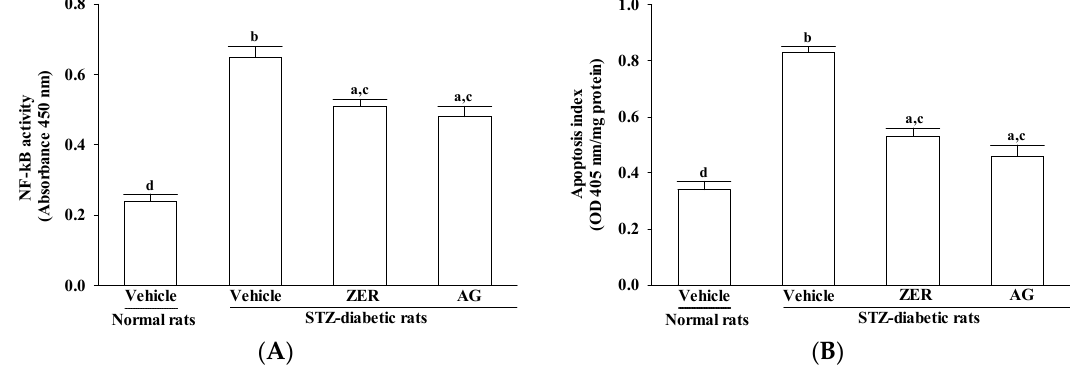
Figure 4. Effects of the treatments on the retinal NF ‐κ B activity ( A ) and apoptosis rate ( B ) in rats. STZ ‐ diabetic rats were administered 40 mg/kg/day ZER, or 50 mg/kg AG by oral gavage once daily for three months. Another group of STZ ‐ diabetic rats and normal rats were administered the same volume of vehicle used to prepare the test medication solutions. Data are mean ± SEM from eight rats per group, and the experiments were repeated independently at least three times with similar results. a p < 0.05 and b p < 0.01 compared to vehicle ‐ treated normal rats, respectively; c p < 0.05 and d p < 0.01 compared to the values of vehicle ‐ treated STZ ‐ diabetic rats, respectively.